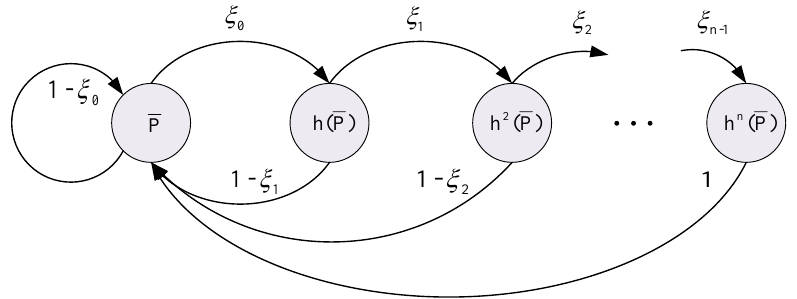
Figure 2. Markov chain transition process of